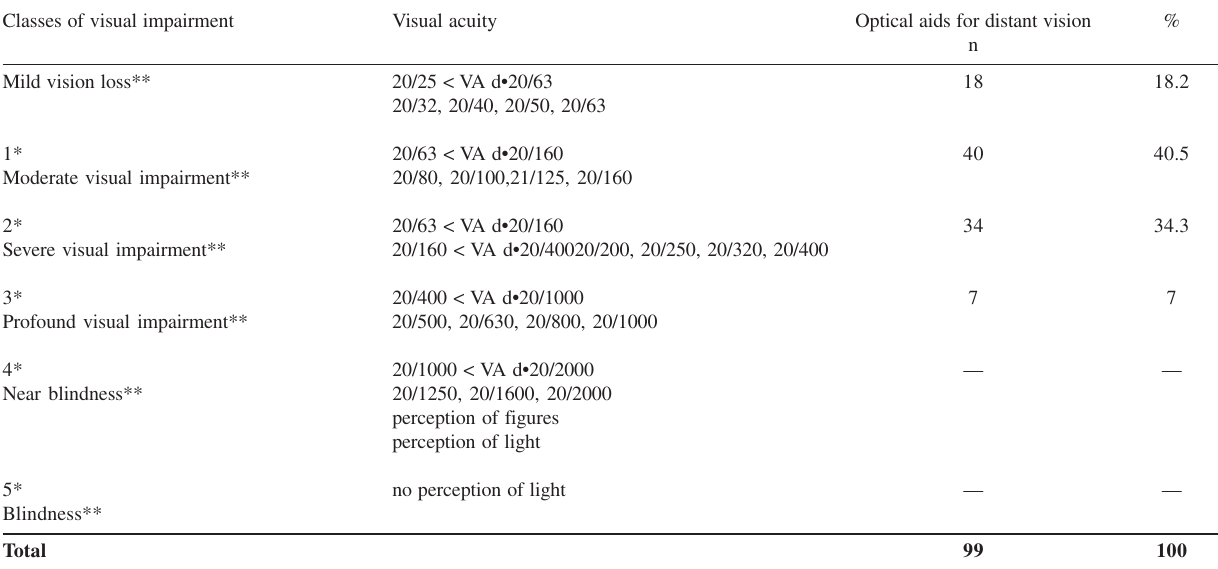
Table 8 - Distribution of prescribed optical aids for far distance by class of visual impairment Classes of visual impairment